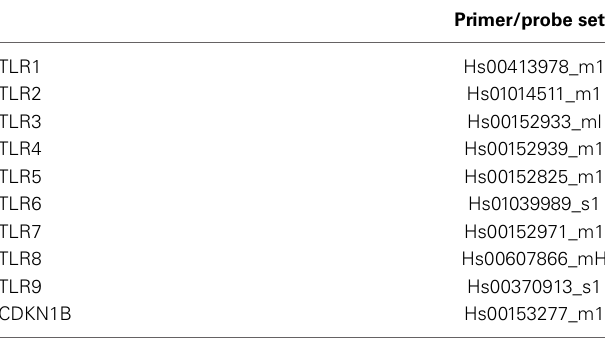
Table 1 | Applied Biosystems primer/probe sets used for realtime qPCR of TLR mRNAs.